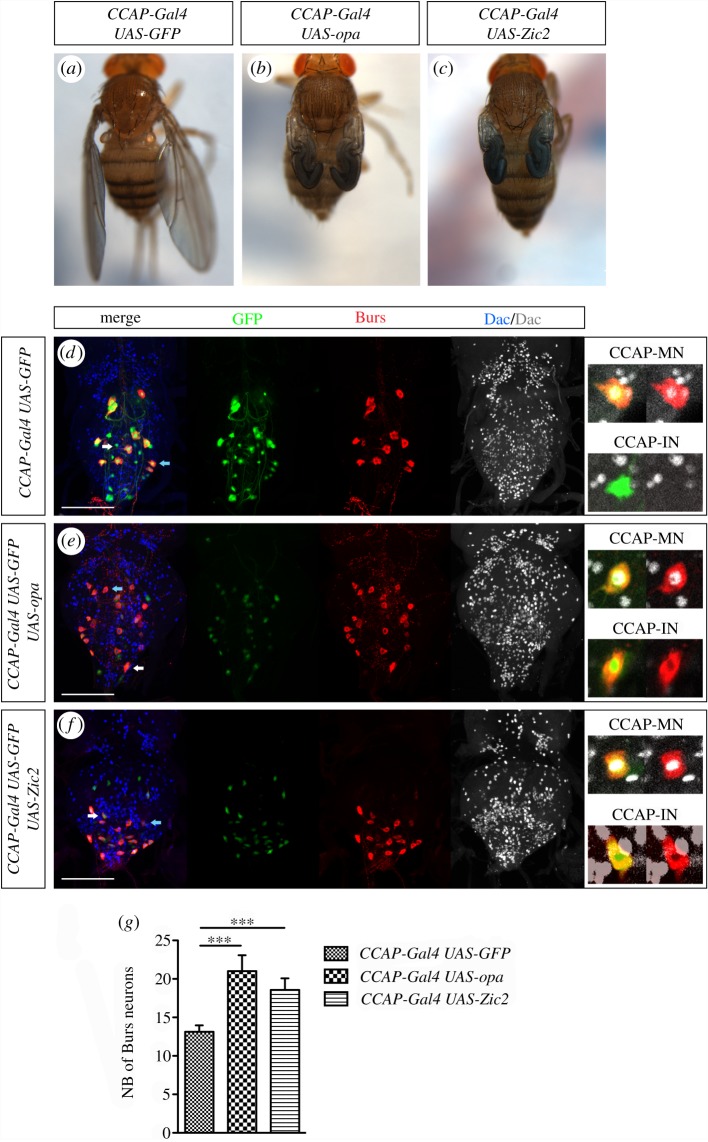
Overexpressing Opa or ectopic expression of Zic2 in the CCAP neurons ectopically activates Burs expression in the CCAP interneurons and affects post-ecdysis maturation. (a) Adult CCAP-Gal4; UAS-GFP flies are used as controls. (b) Overexpression of Opa in the CCAP neurons causes defects in adult ecdysis: wings do not expand, the thorax fails to stretch, the cuticle is matte but the pigmentation is similar to control (100%, n = 83). (c) Ectopic expression of Zic2 is also able to alter the post-ecdysis maturation but with a less frequency (30%, n = 93). Pictures in (a–c) were taken from 3 h-old adults. (d) Control adult VNC expressing CCAP-Gal4 UAS-GFP and stained for Burs and Dac. (e) Overexpression of Opa in the CCAP neurons (same genotype as in (b)) leads to a general decrease of CCAP expression, but also to an ectopic expression of Burs in the CCAP interneurons. (f) Flies with the stronger phenotype after ectopic expression of Zic2 in the CCAP neurons (VNC are dissected from flies of the genotype presented in (c)). Flies have similar alterations as the ones shown in (e). VNC in (e,f) were dissected from 0 to 1 h-old adults. The inserts in (d–f) are zoom of a CCAP motoneuron (CCAP-MN, marked by a blue arrow) and a CCAP interneuron (CCAP-IN, marked by a white arrow in the merge panels). Scale bar, 100 µm. (g) Statistical analysis of cells expressing Burs in CCAP-Gal4 UAS-GFP flies, n = 8; mean of number of neurons expressing Burs per VNC = 13,1 (s.e.m. ± 0,3). And in CCAP-Gal4 UAS-opa flies, n = 7; mean of number of neurons expressing Burs per VNC = 21,0 (s.e.m. ± 0,8). For CCAP-Gal4 UAS-Zic2, n = 7; mean of number of neurons expressing Burs per VNC = 18,6 (s.e.m. ± 0,6). ****p-value < 0.0001.